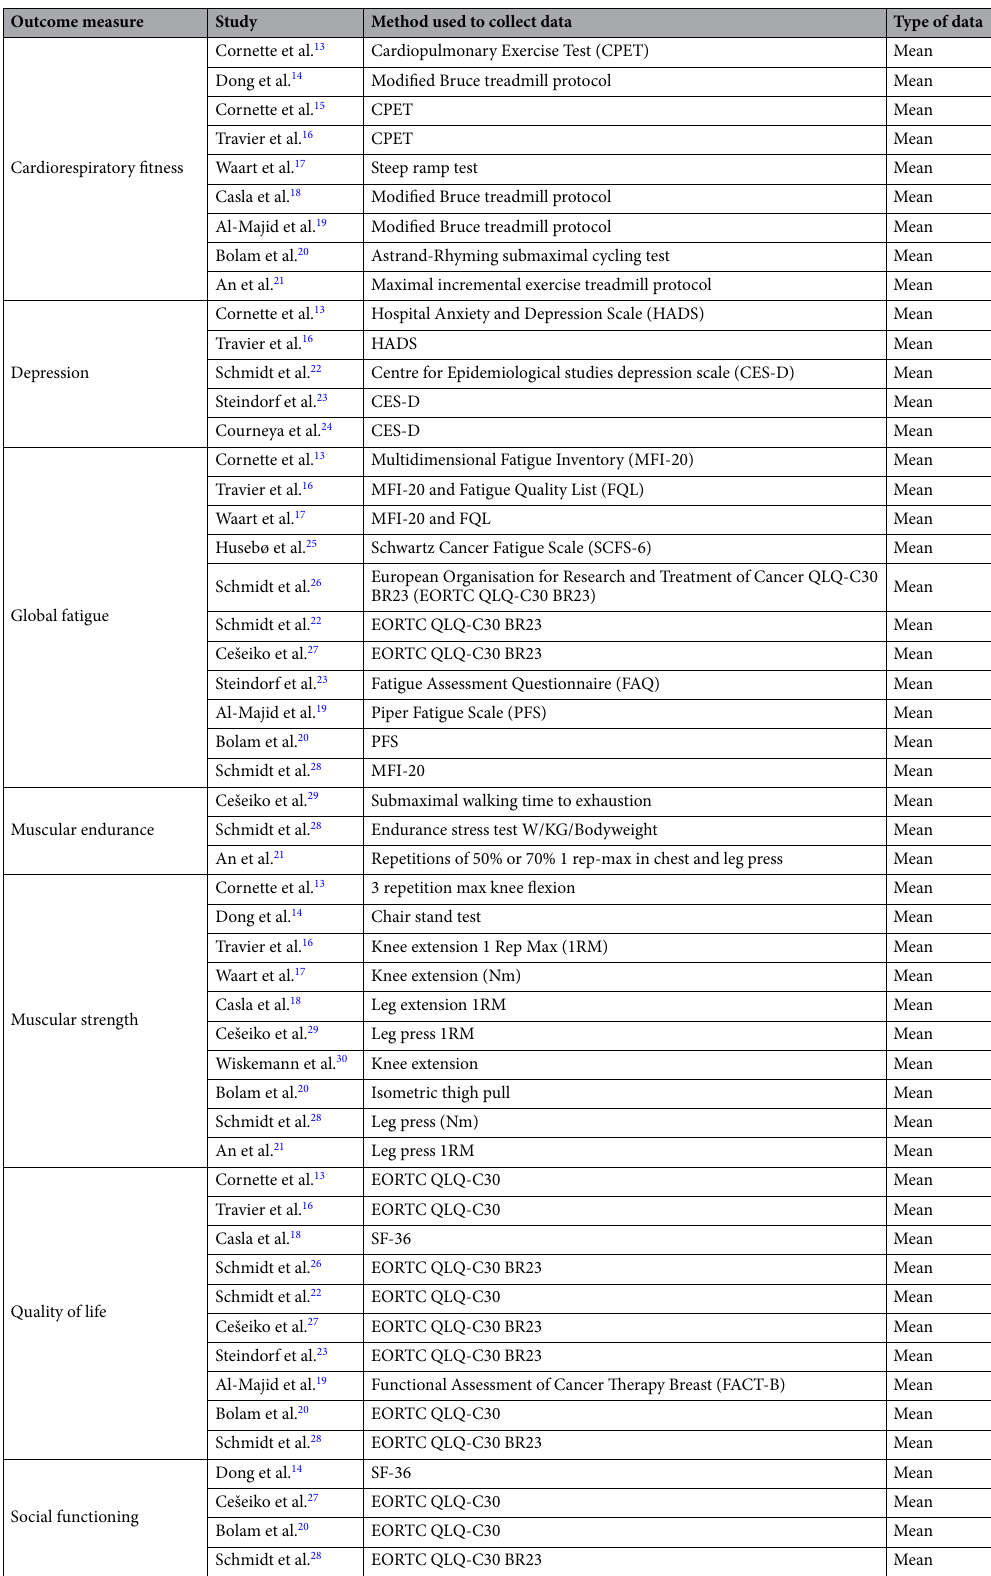
Table 1. Information to further define the outcome measures used in these meta-analyses including which studies they were used in, how they were collected by each study and what type of data they